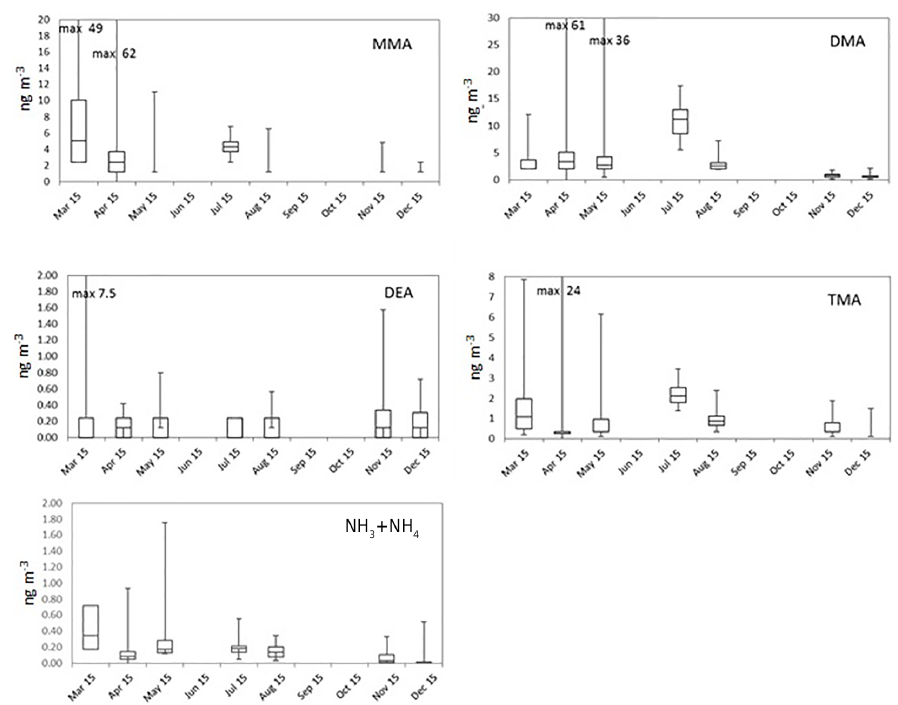
Figure 1. Monthly box-and-whisker plots of the most abundant amines (tot) and summed up ammonia and ammonium. The boxes represent the second and third quartiles and the lines in the boxes the median values. The whiskers show the highest and the lowest observations. Table 2. Ratio of gas and aerosol phases. N (g) indicates the number of gas-phase data above the detection limit (DL), N (a) indicates the number of aerosol-phase data above the DL, and N indicates the number of data above the DL at the same time both in the gas and aerosol phases; ratio is gas / (gas + aerosol) (when both values were above the DL). MMA DMA